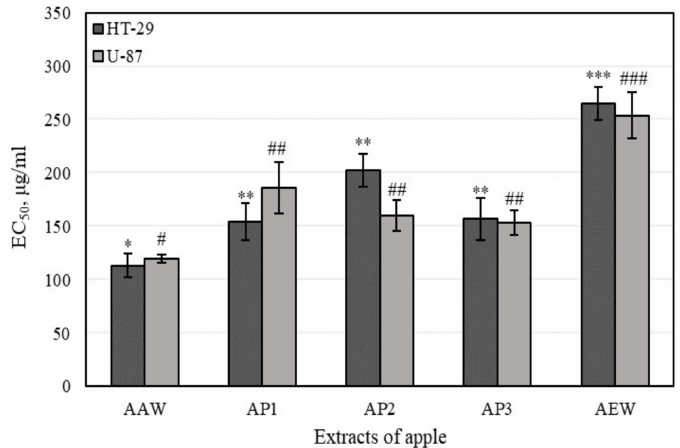
Figure 8. The effect of apple extracts on cell viability evaluated by MTT assay. Different signs (* and #) indicate statistically significant differences at p > 0.05, according to Tukey’s multiple comparison